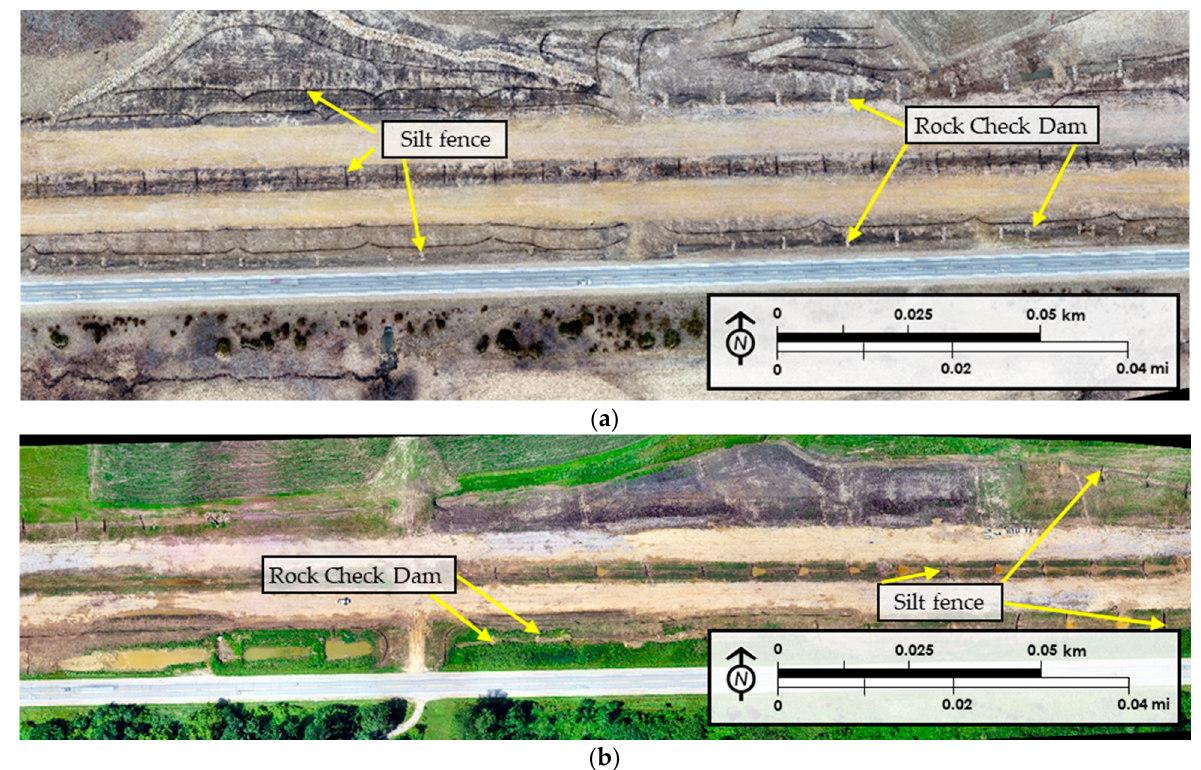
Figure 3. U.S. 30 highway construction site layout views: ( a ) 28 March 2019: ( b ) 18 July 2019.